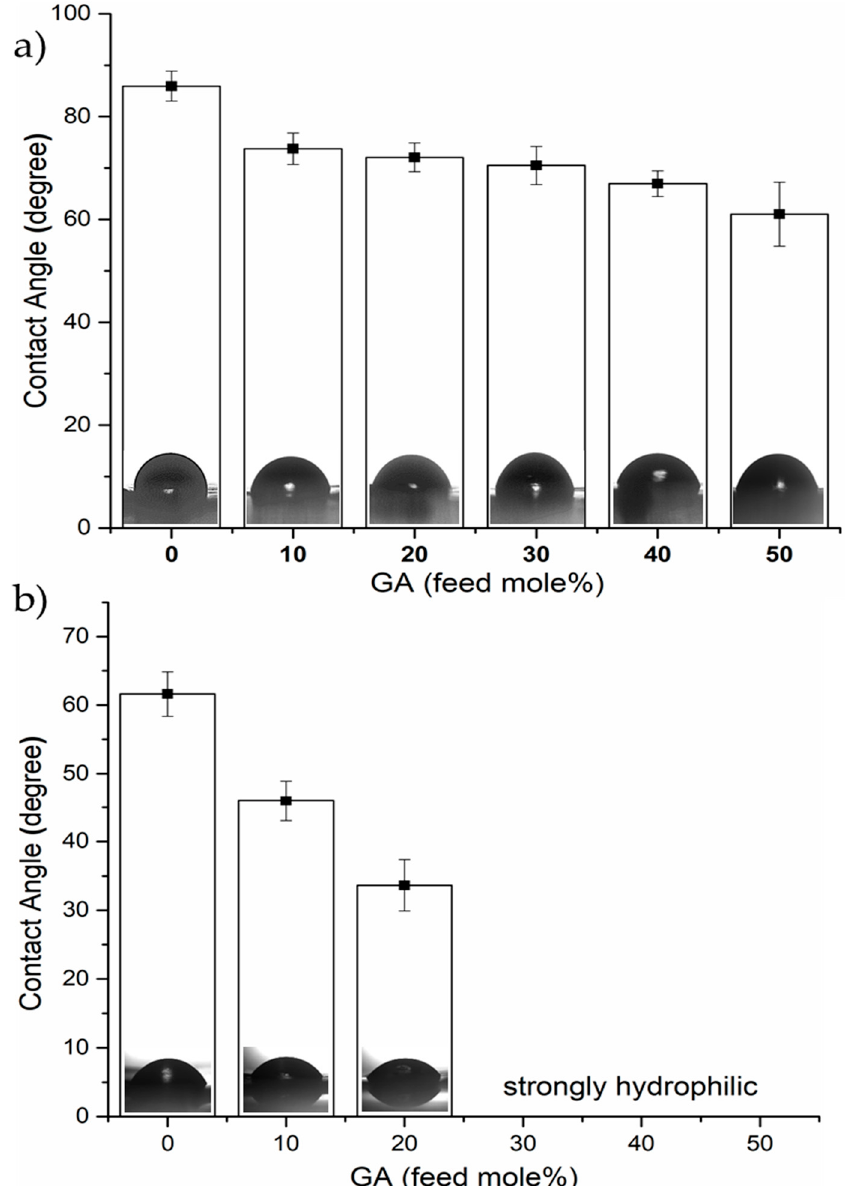
Figure 7. Water contact angle characterization of homo- and co-polymer films prior to and after plasma treatments.